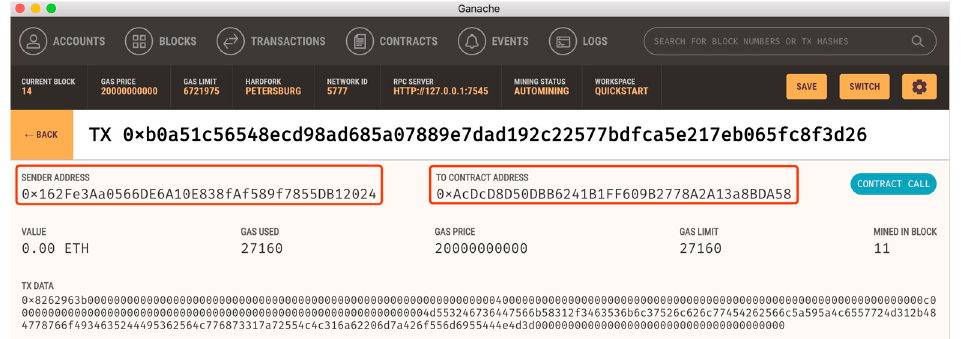
Figure 8. Data in the V-chain blocks are encrypted.